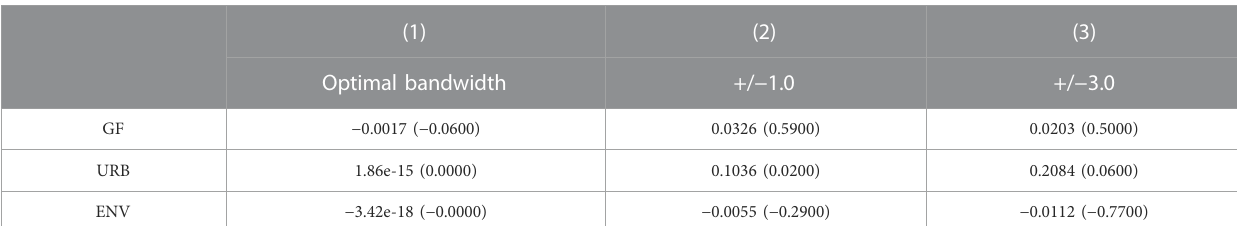
TABLE 2 Diagnostic tests.